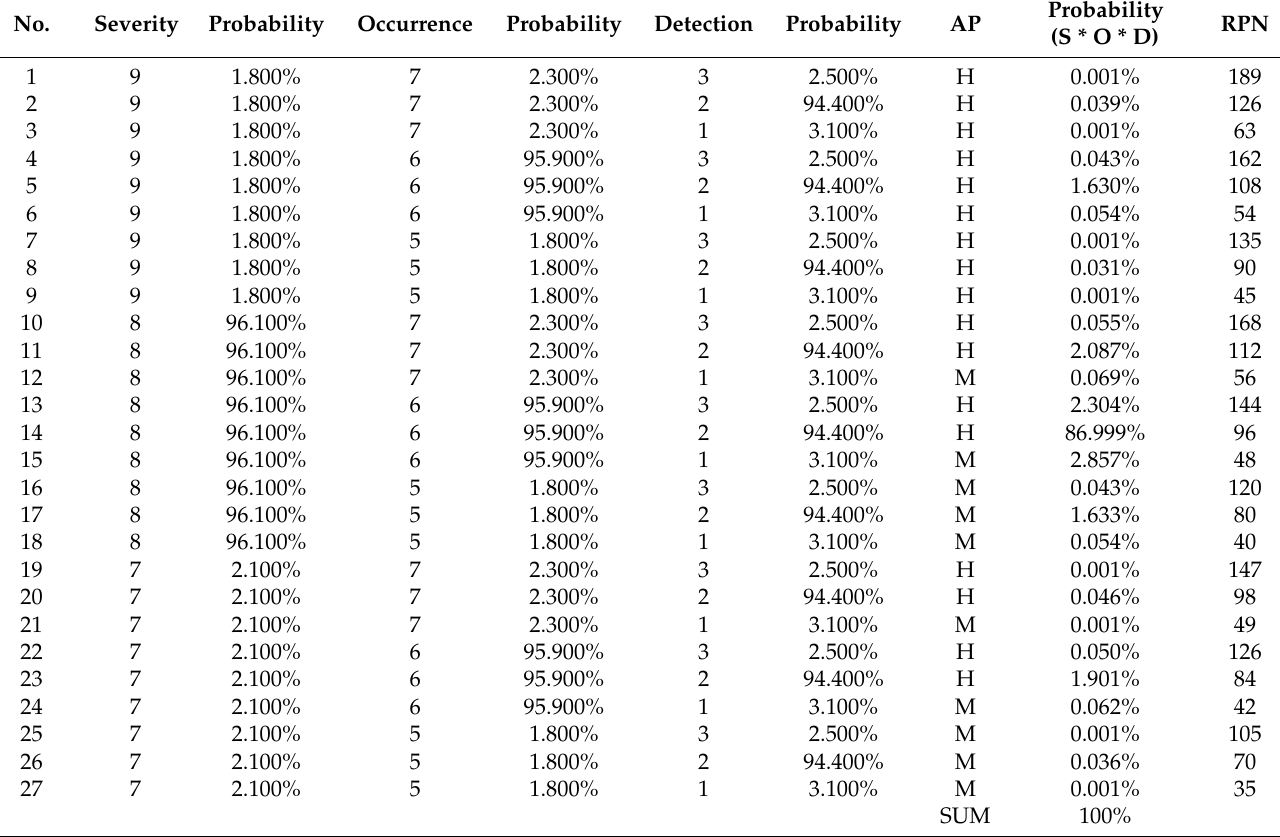
Table 4. Case 1: Order, probability, AP, and RPN for 27 combinations of S, O, and